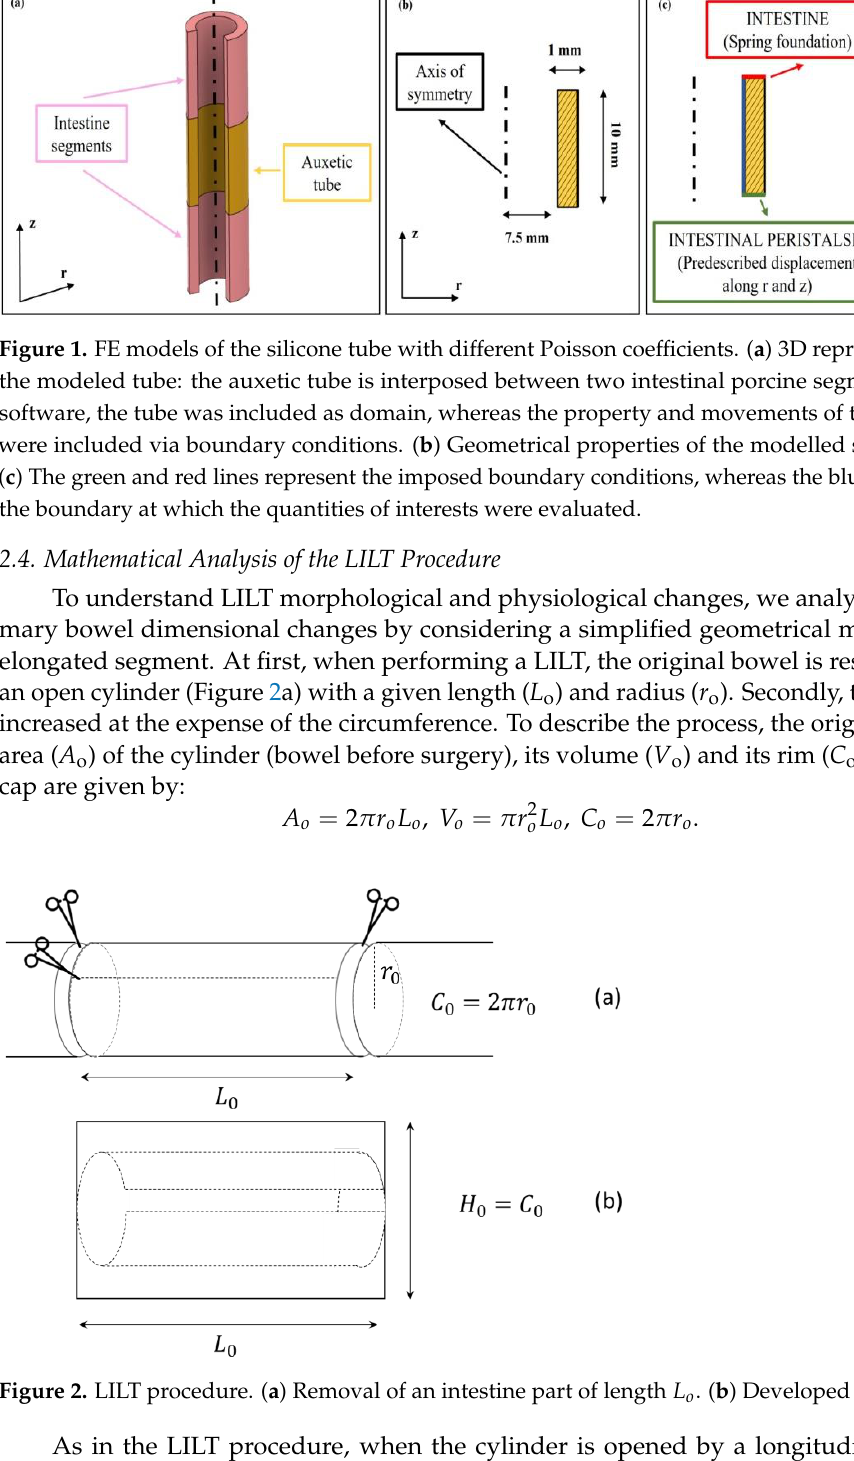
Figure 1. FE models of the silicone tube with different Poisson coefficients. ( a ) 3D representation of the modeled tube: the auxetic tube is interposed between two intestinal porcine segments. In the software, the tube was included as domain, whereas the property and movements of the intestines were included via boundary conditions. ( b ) Geometrical properties of the modelled silicone tube. ( c ) The green and red lines represent the imposed boundary conditions, whereas the blue line shows the boundary at which the quantities of interests were evaluated. Table 1. Properties of the involved structures.